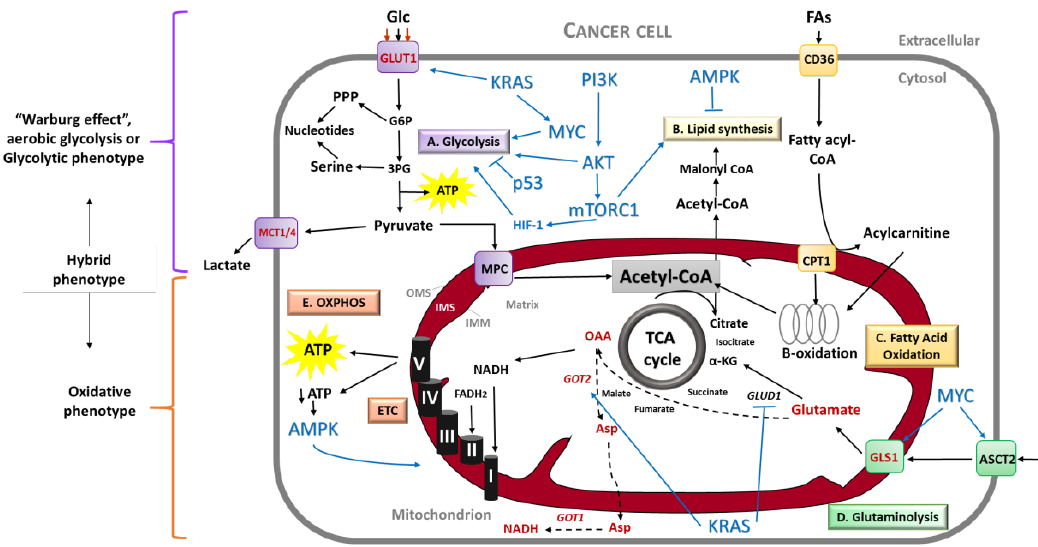
Figure 1. Metabolic reprogramming in cancer. In contrast with normal cells, cancer cells are able to fulfill their metabolic needs with minimal dependence on extrinsic stimuli by growth factors, through deregulation of pathways related to energy production and biosynthesis. Glycolysis and glutaminolysis are by far the most investigated pathways. The most common signaling molecules involved in metabolic pathways are PI3K, AKT, mTORC1, AMPK, as well as the oncogenic proteins KRAS and MYC, and the tumor suppressor p53 (depicted in blue font). A . Glycolysis. The “Warburg effect” or aerobic glycolysis is characterized by high glycolytic rates observed in cancer cells even in the presence of oxygen, with a consequent high amount of lactate production. KRAS induces glucose (Glc) uptake by cancer cells through upregulation of the GLUT1 transporter. The glycolysis pathway is promoted by KRAS, MYC, AKT, loss of the tumor suppressor TP53 and HIF-1. Additionally, glycolytic intermediates are diverted towards biosynthetic processes, mainly DNA and RNA synthesis by the Pentose Phosphate Pathway (PPP). Glycolysis allows the production of pyruvate and ATP. Pyruvate can be converted into lactate and shuttled outside the cell; PDAC cells have enhanced activity of MCT1 / 4. Pyruvate can also enter the mitochondria through the MPC for further feeding the TCA cycle. B . Lipid synthesis. Cancer cells activate lipid synthesis (also named fatty acid synthesis or lipogenesis) to meet their demands. This pathway requires the production of cytosolic Acetyl-CoA, which is mainly derived from mitochondrial citrate into the TCA cycle. C . Fatty Acid Oxidation (FAO). FAO comprises a cyclical series of reactions that result in the shortening of fatty acids (FAs) molecules (beta-oxidation) to produce Acetyl-CoA and NADH / FADH 2 . CPT1, the rate-limiting enzyme of FAO, conjugates fatty acids with carnitine to translocate them into the mitochondria, where the acylcarnitines undergo B-oxidation. D . Glutaminolysis. In PDAC, KRAS and MYC also rewires glutamine (Gln) metabolism. Gln is